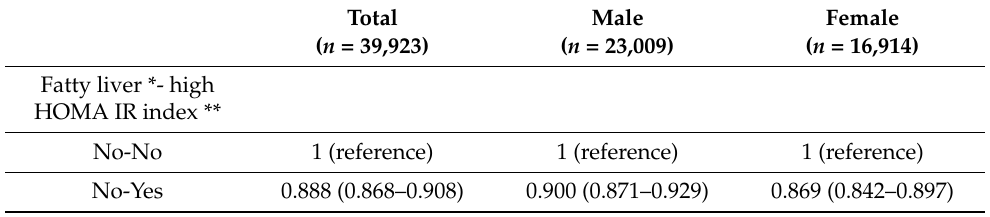
Table 5. Association of NT-proBNP with fatty liver and HOMA-IR score, accounting for